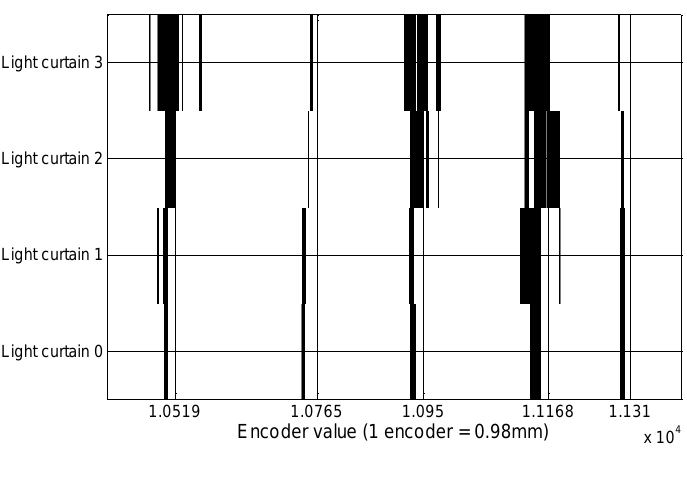
Figure 8. The x-axis grid shows the location of the trees detected with the light curtain sensor, and the y-axis shows which the light curtain sensor that is blocked by the tree in each location.